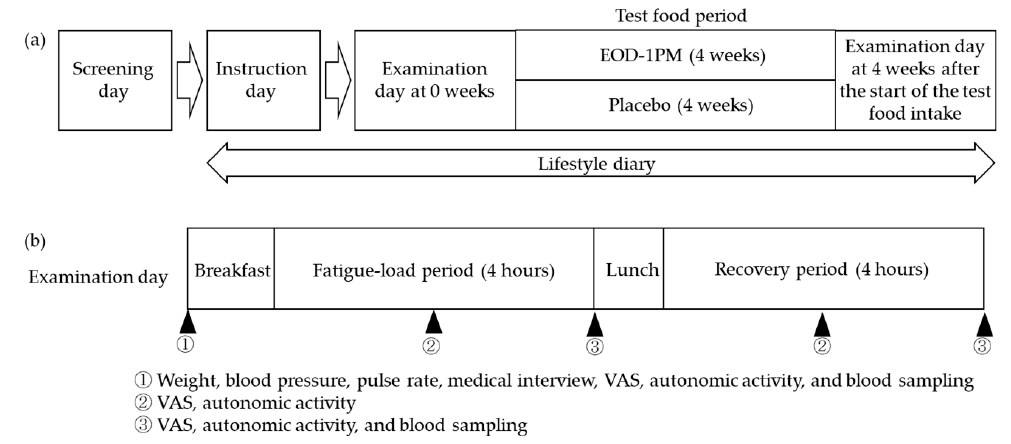
Figure 1. Study design and endpoints: ( a ) overall trial schedule, ( b ) examination schedule. EOD-1PM, food containing paramylon derived from Euglena gracilis EOD-1; VAS, Visual Analogue Scale.